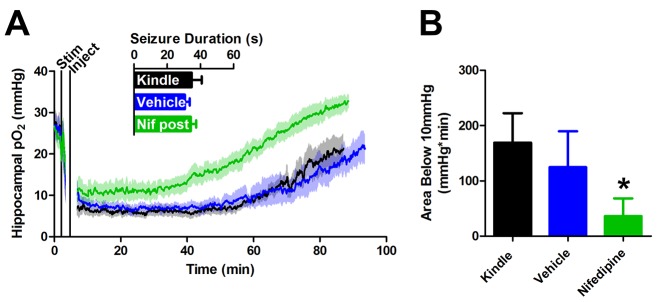
Post-seizure administration of nifedipine prevents severe postictal hypoxia.(A) Nifedipine (15 mg/kg) was administered immediately after a seizure. No differences were observed in seizure duration, however nifedipine initiated a quicker return to baseline pO2(n = 5). (B) Quantification of (A). Nifedipine (post-seizure administration) caused a significant reduction in severe hypoxia. *p<0.05.